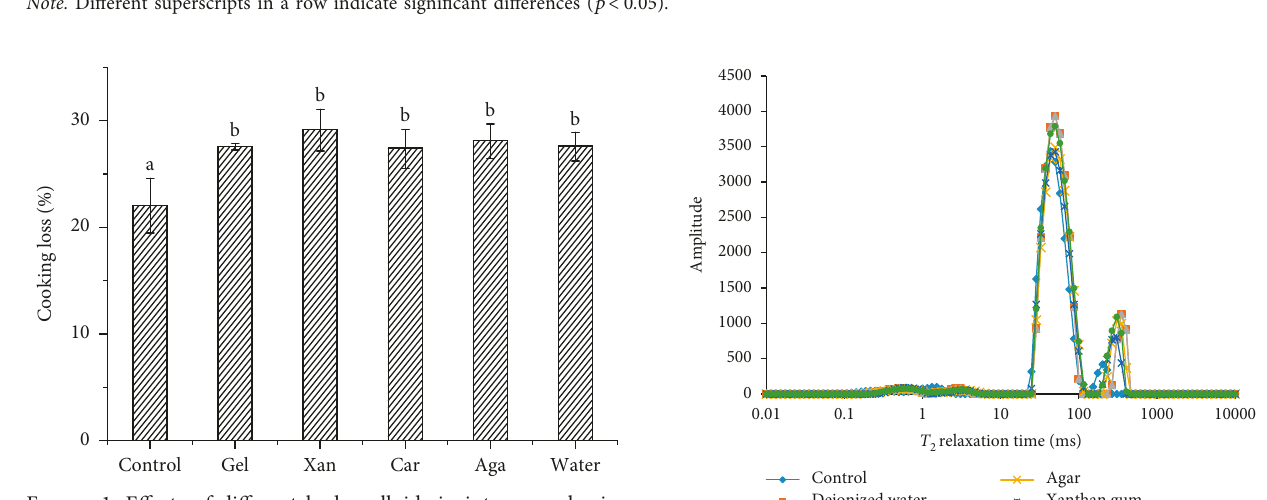
Figure 1: Effects of different hydrocolloids in intramuscular in- jection on the cooking loss of porcine meat.